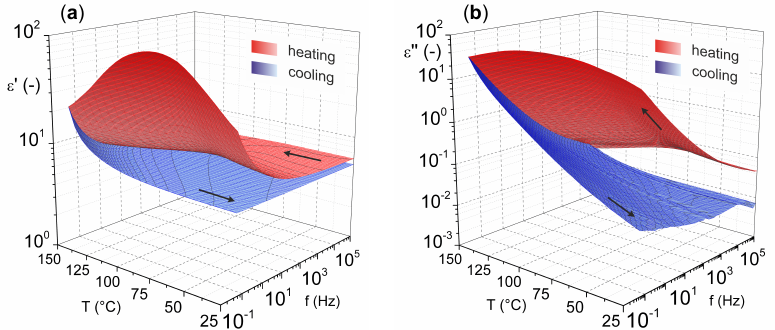
Figure 4. Temperature–frequency dependence of complex permittivity: ( a ) real part and ( b ) imaginary part (reprinted from article [46] distributed under the terms and conditions of the Creative Commons Attribution (CC BY)